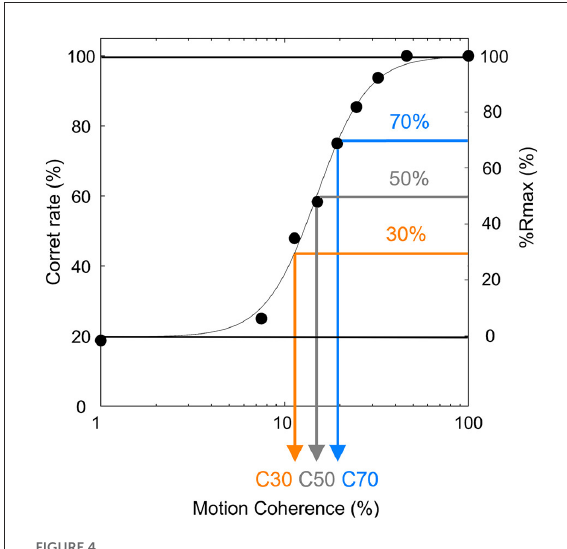
FIGURE4 Typical result of a preliminary experiment session of the MDD task. The difference between the maximum correct rate and minimum correct rate was set to 100% (Rmax), and motion coherence values with 30, 50, and 70% Rmax (defined as C30 (orange), C50 (gray), and C70 (blue), respectively) were calculated.